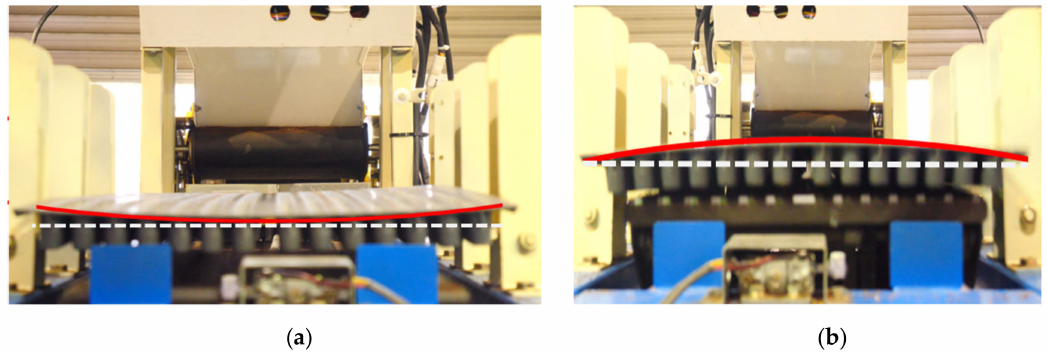
Figure 20. Deformation of pot tray by ( a ) dynamic impact and ( b ) contact.